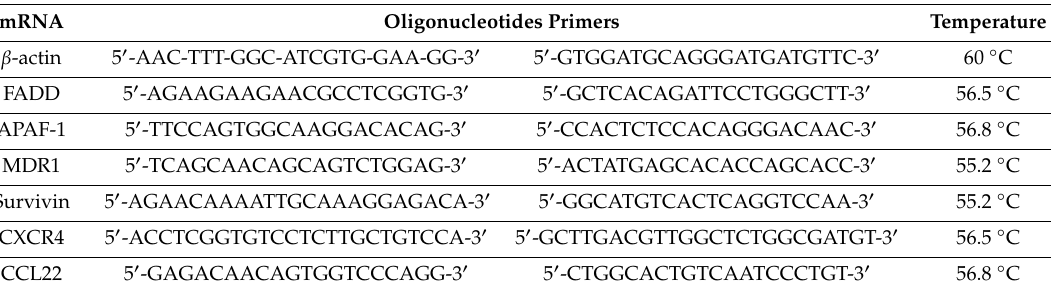
Table 2. Primer sequences used for